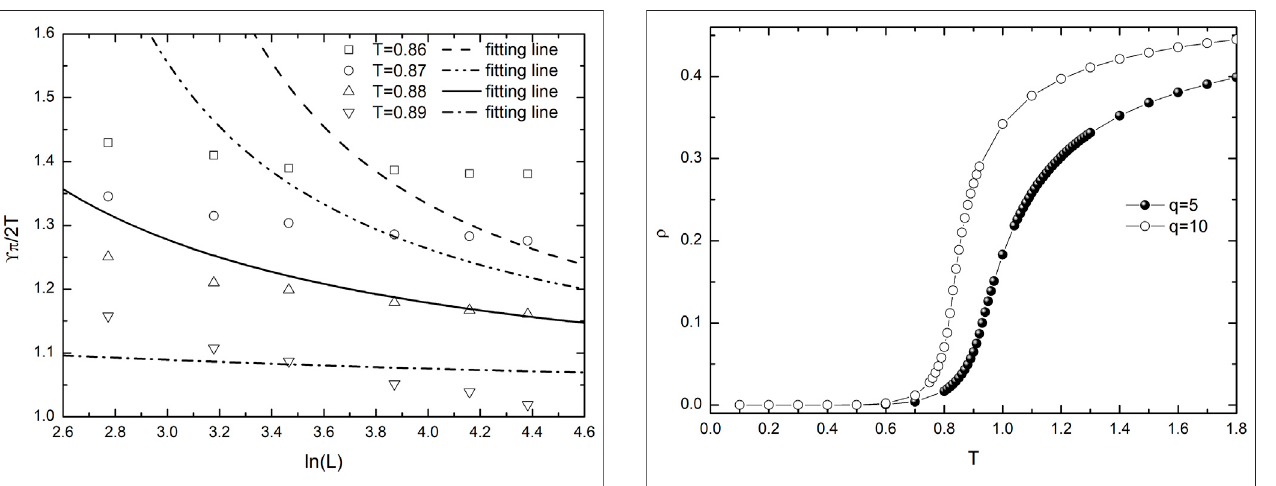
FIGURE 2 | Application of the fi nite-size scaling of  ( T ) to estimate the critical temperature for q (cid:1) 5. The lines are fi ts to the fi nite-size scaling relation of Eq. 4 .